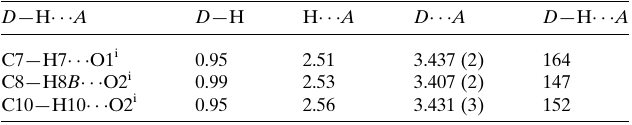
Table 1 Hydrogen-bond geometry (A˚ , (cid:2) ).